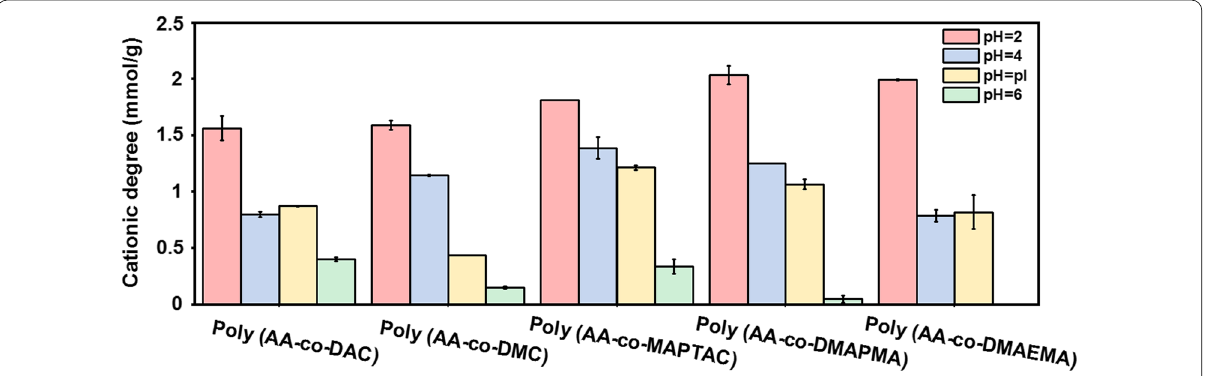
Fig. 5 The cationic degree of AAPs under different pH conditions